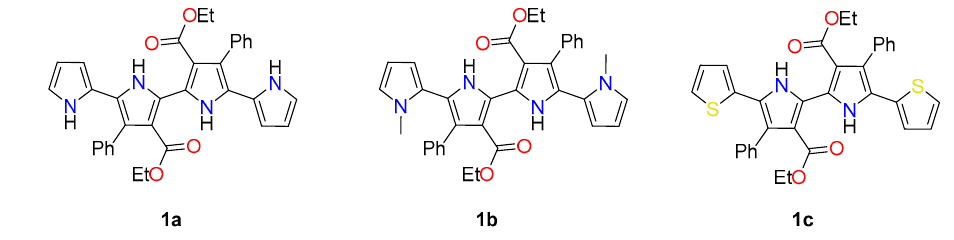
(cid:48) -bipyrroles 1a – c